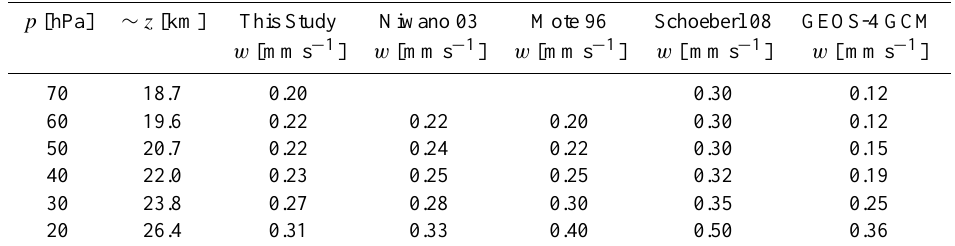
Table 1. Comparison of tropical ascent rates w [mms − 1 ] in the lower stratosphere from different studies. Niwano et al. (2003) and Mote et al. (1996) used HALOE satellite observations and averaged between ± 12.5 ◦ , Schoeberl et al. (2008) used a combination of 15yr of HALOE and Aura/MLS H 2 O observations to compute w at the Equator. They also displayed results of the GEOS-4 general circulation model. Ascent rates are increasing with altitude and very similar to each other. However, the GEOS-4 model underestimates the observations. The slow tropical ascent is in contrast to the faster meridional speed ( ∼ 1ms − 1 ).